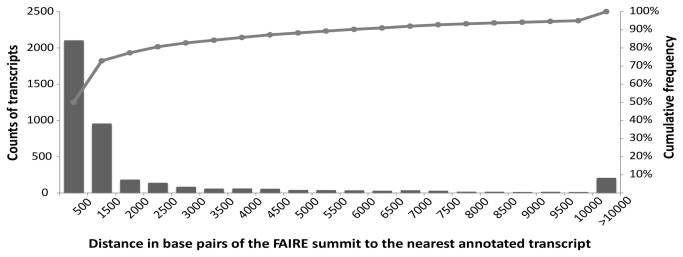
Cumulative histogram of the approximate distances of FAIRE summits from their next closest annotated gene.Genomic coordinates were used to calculate the distances between FAIRE summits and the start and stop codons of their nearest gene transcripts. The number of transcripts with at least one FAIRE peak assigned was counted and the distances to the start or stop codons computed. The gray line indicates the cumulative percentage of the transcripts to which FAIRE peaks were assigned. As seen, approximately 80% of the FAIRE summits were located within 1.5 kb up- or downstream of the transcript´s start or stop codon. FAIRE peaks were detected using MACS tool v. 1.4.0beta, with a p-value cutoff equal to 10-05.